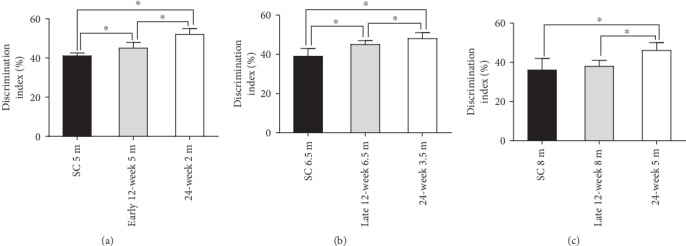
Effects on NOR task recognition memory of different exercise durations. Data from exercised APP/PS1 mice that were the same age at the end of the observation period are shown. (a) APP/PS1 mice aged 5 m in the early 12-week group and 2 m in the 24-week group (which were all the same age at the end of the observation period) were paired, while the sedentary control mice aged 5 m in the early 12-week group served as the negative controls. (b) APP/PS1 mice aged 6.5 m in the late 12-week group and 3.5 m in the 24-week group (which were all the same age at the end of the observation period) were paired, while the sedentary control mice aged 6.5 m in the late 12-week group served as the negative controls. (c) APP/PS1 mice aged 8 m in the late 12-week group and 5 m in the 24-week group (which were all the same age at the end of the observation period) were paired, while the sedentary control mice aged 8 m in the late 12-week group served as the negative controls. SC: sedentary control; TE: treadmill exercise. ∗P < 0.05.